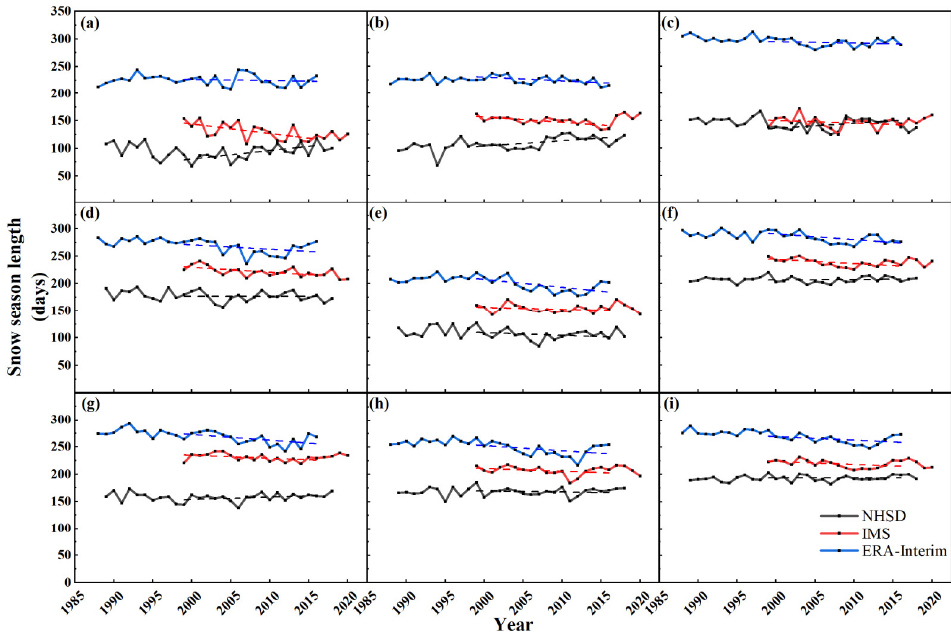
Figure A3. Comparison of the SSL derived from NHSD, IMS, and ERA-Interim in typical areas. The typical areas are ( a ) the Alps, ( b ) the Rocky Mountains, ( c ) the Qinghai–Tibet Plateau, ( d ) Alaska, ( e ) the Eastern European Plain, ( f ) the Eastern Siberian Mountains, ( g ) Northern Canada, ( h ) the West Siberian Plain, and ( i ) the Central Siberian Plateau.